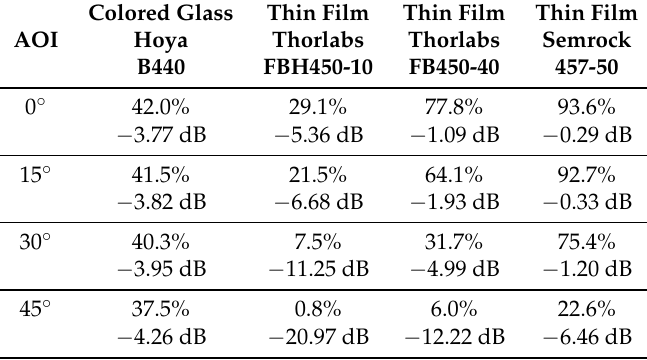
Table 3. Calculated rates of passed radiated power for different LED-filter combinations at various AOIs, based on measured LED spectra and filter transmission curves. These values are equal to signal power loss caused by the optical